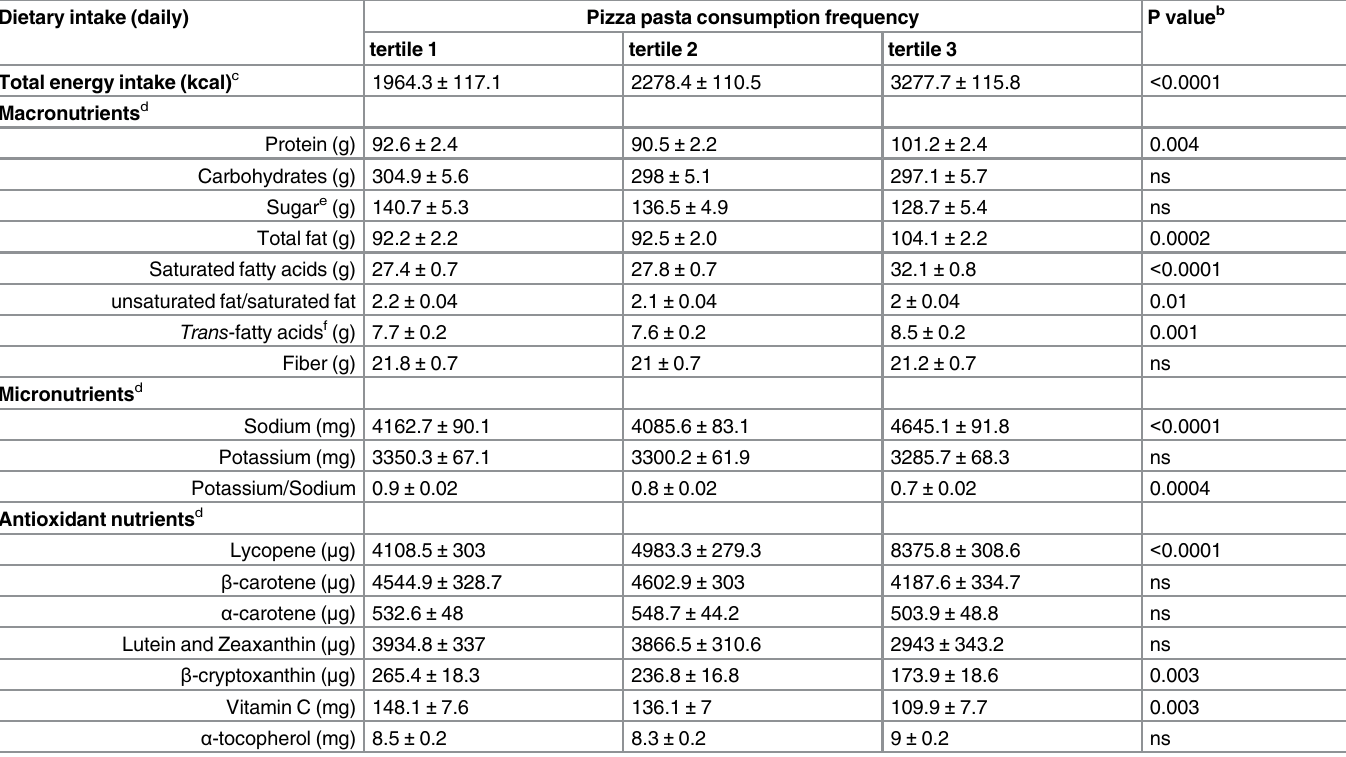
Table 2. Dietary intakes among study participants (n = 369) across the pizza and pasta consumption frequency tertiles a . Dietary intake